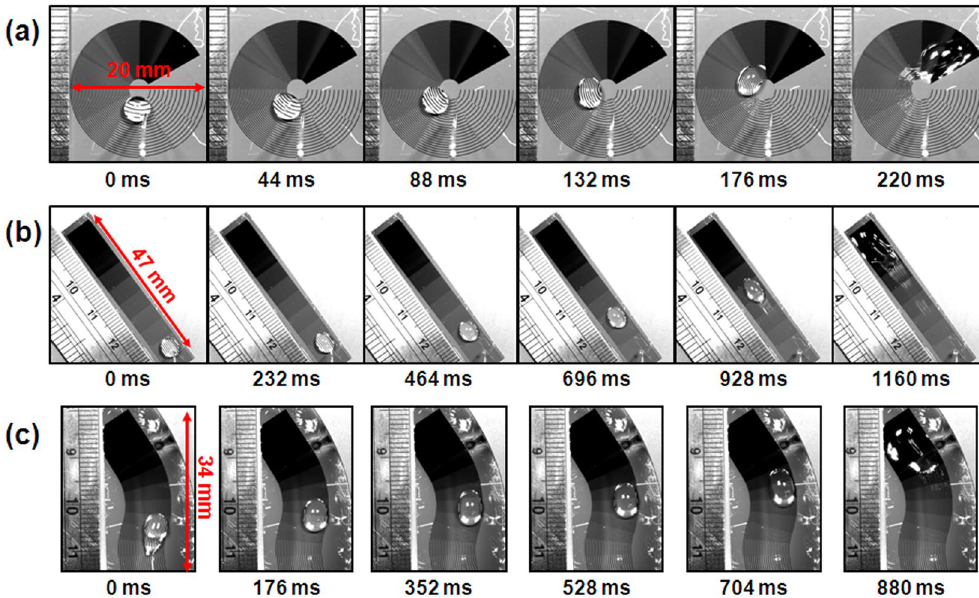
Figure 6. Three surfaces with arbitrary paths are designed for large volume droplet transport. The pattern density on these surfaces range from 0 to 1, and the CA gradient of the three surfaces are over 150°. ( a ) Droplet self-propulsion on annular path, which has an inner diameter of 3 mm and outer diameter of 20 mm, droplet could rotate about 210° around the center. ( b ) Droplet self-propulsion on straight path, the total length of the path is about 47 mm, and the droplet achieved a displacement of 37.5 mm ( c ) Droplet self-propulsion on ‘S’ shape path, the path has a length of 34 mm between two